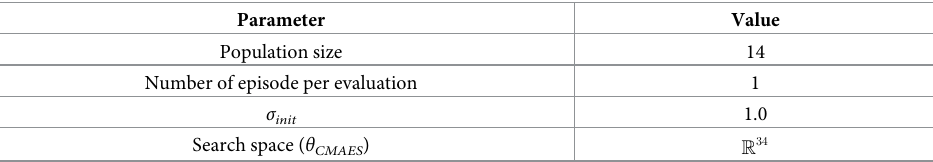
Table 2. Parameters for the CMAES